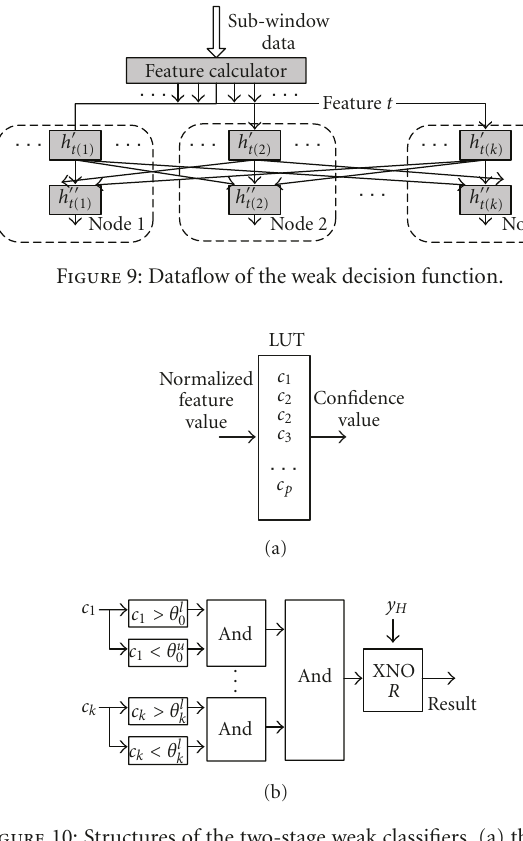
Figure 10: Structures of the two-stage weak classifiers. (a) the first stage; (b) the second